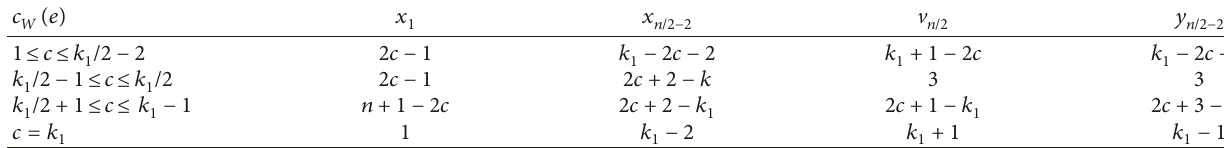
u c is even. c c , when